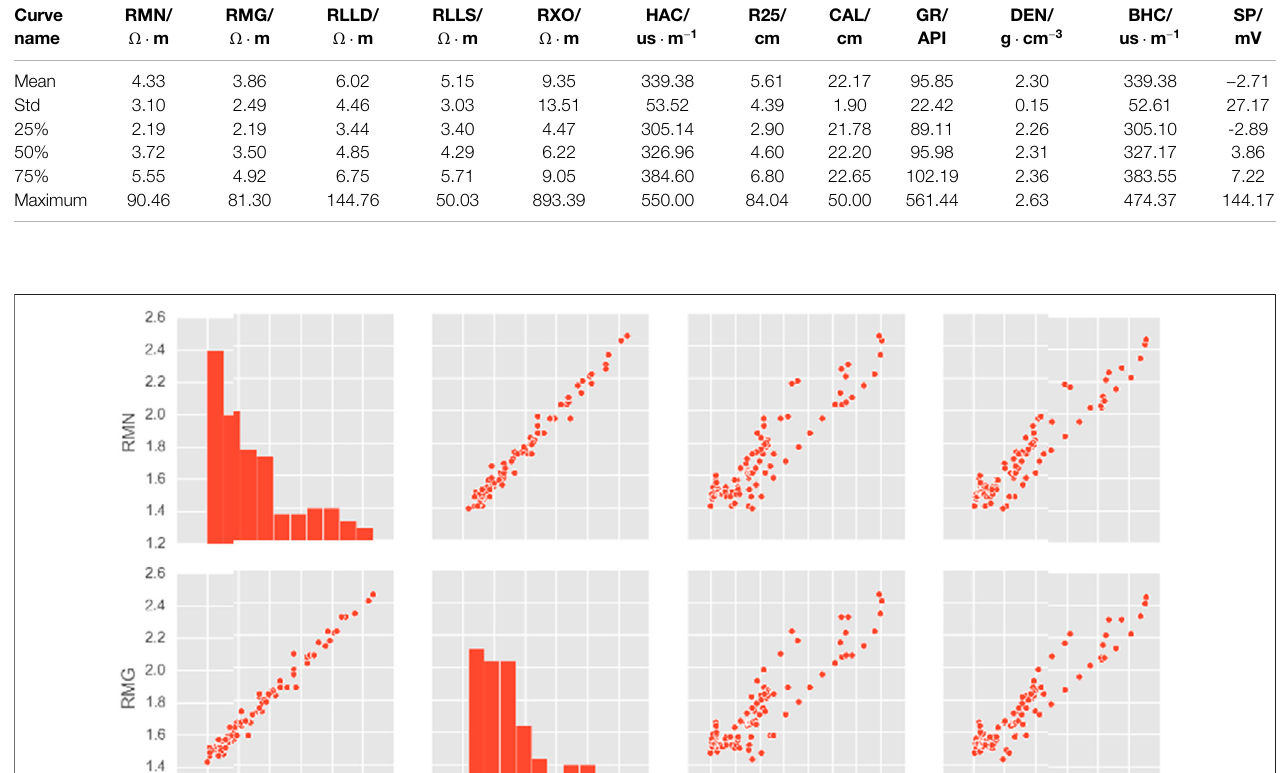
Frontiers in Earth Science |